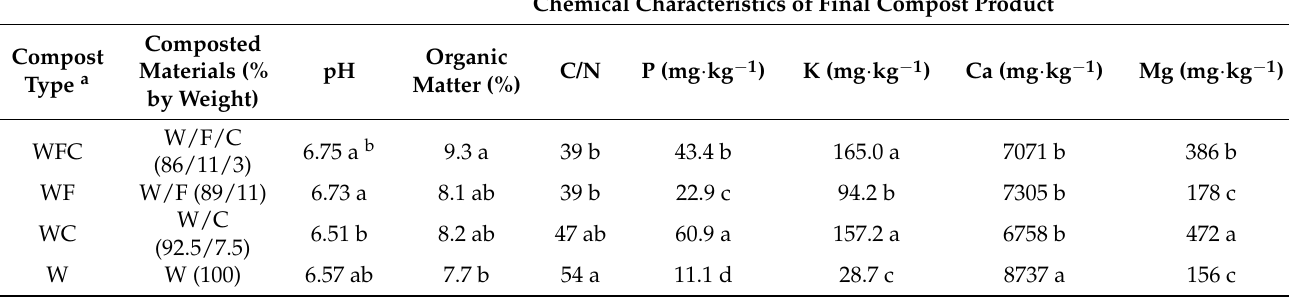
Table 2. Percent weights of original materials composted to create Compost WFC, Compost WF, Compost WC, and Compost W, utilizing wood chips from untreated pallets and mixed tropical tree debris (W), food waste (F), and chicken manure (C); and chemical characteristics of final compost products prior to testing their effects on growth of lettuce in pot culture. Chemical Characteristics of Final Compost Product